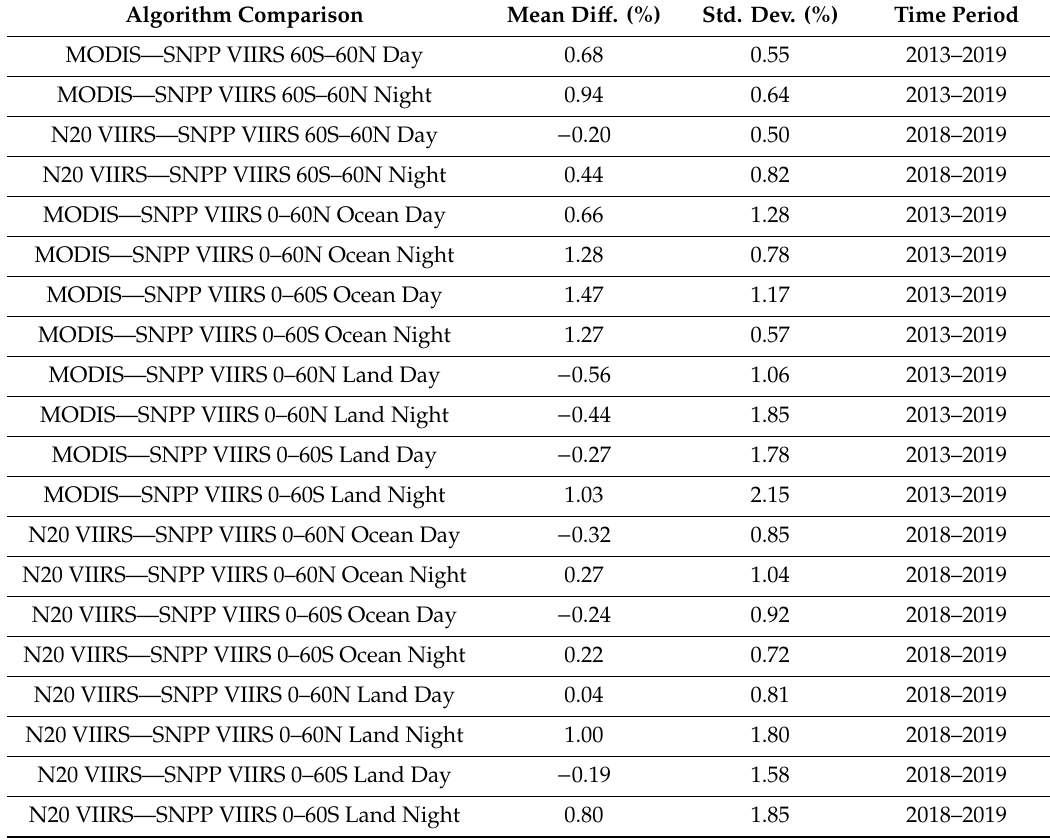
Table 4. Mean and variabilities of day-to-day cloud fraction di ff erences between the MVCM algorithms (Aqua MODIS, SNPP VIIRS, NOAA-20 VIIRS) Bolded values are for entire 60S–60N latitude bands. Algorithm Comparison Mean Di ff . (%) Std. Dev. (%) Time